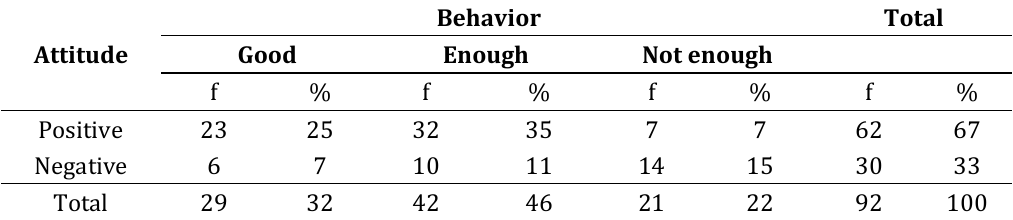
Distribution of frequency and percentage of preventive behavior of increasing uric acid levels Behavior Total Attitude Good